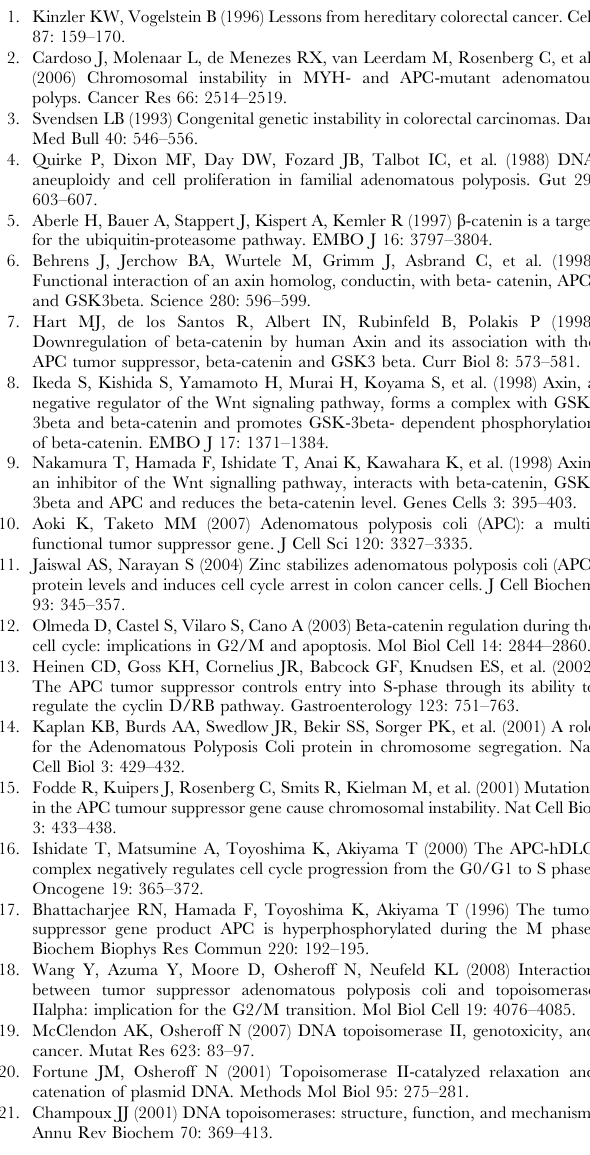
Table S5 Cell cycle distribution of HCT116 b m cells expressing GFP, M2-APC, or M3-APC. Cell cycle distributions of GFP, M2- APC, and M3-APC expressing cells at 48 hours post-transfection. For each transfection, 10,000 GFP-positive cells were analyzed. Table shows the average from three independent experiments. Found at: doi:10.1371/journal.pone.0009994.s005 (0.03